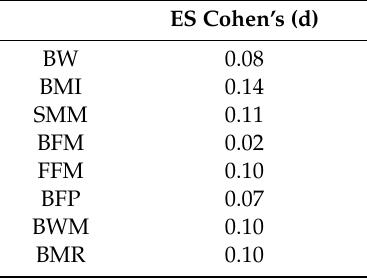
Figure 6. Alteration of BC during RF in subgroup male ( n = 19) of and female ( n = 15). (a–e) significant difference between male and female at T1, T2, T3, T4 and T5, respectively. ( A : Body weight; B : Body mass index; C : Body fat mass; D : Body fat percentage; E : Skeletal muscle mass; F : Fat free mass; G : Body water mass; H : Basal metabolic rate). Data presented in mean and SEM. * p < 0.05; ** p < 0.01.